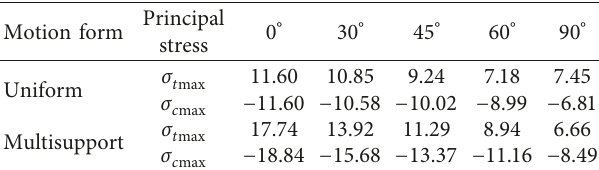
Table 5: Maximum stresses of tunnel body at different incident